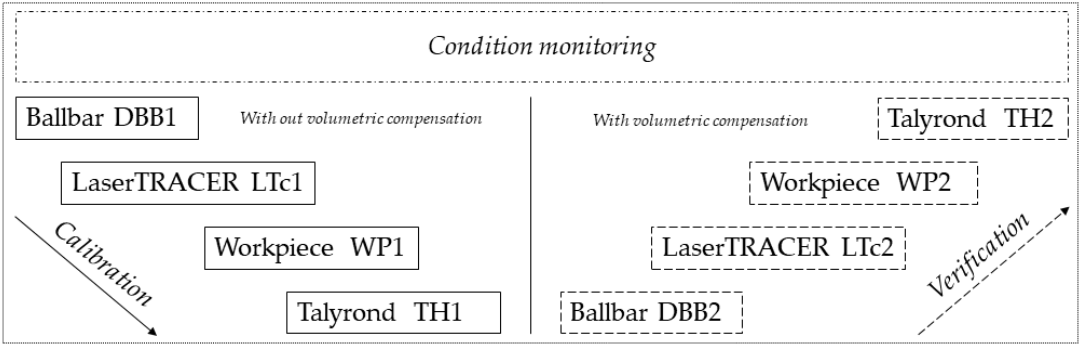
Figure 1. Experiment setup.